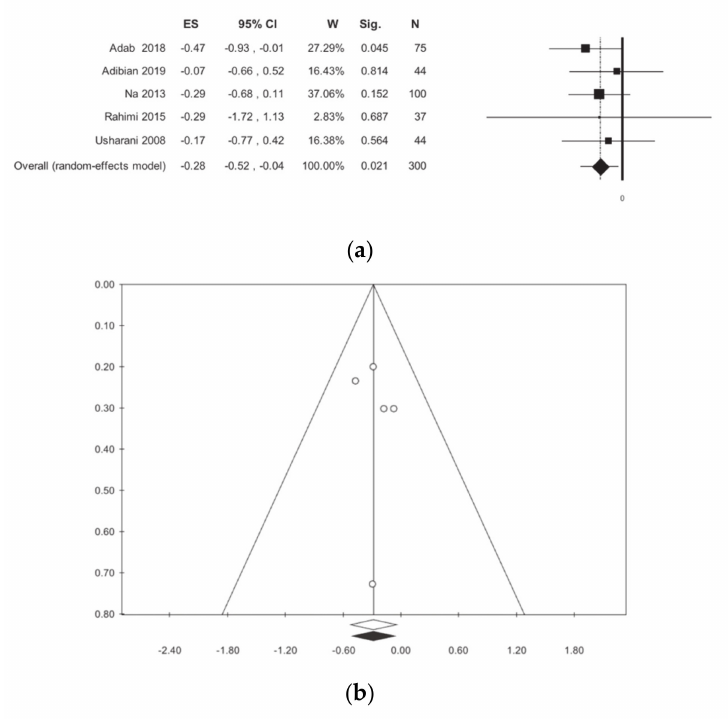
Figure 6. Meta-analysis results according to low-density lipoprotein (LDL): ( a ) forest plot ( b ) funnel